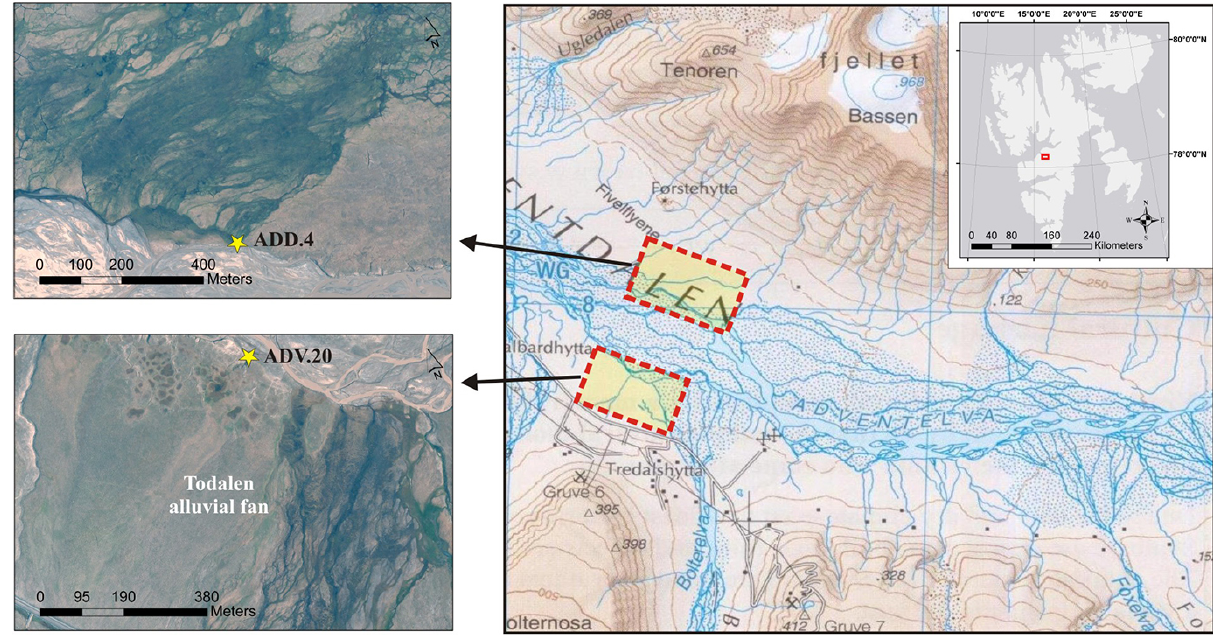
Figure 1. Location of Adventdalen in Svalbard (right) and position of the sites (left).